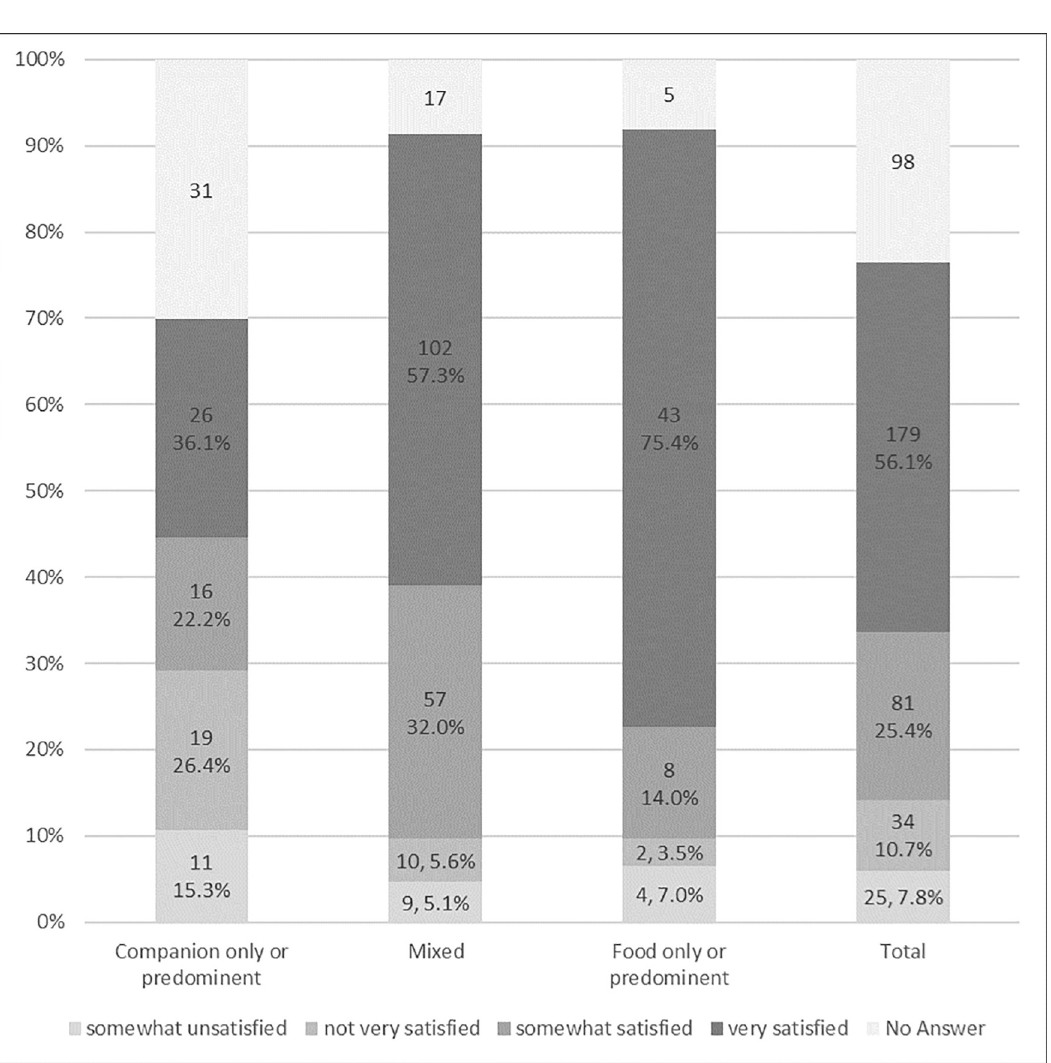
Fig 5. Satisfaction level of small-scale livestock and poultry owners by type of veterinarian practice in 4 western states (Washington, California, Colorado and Oregon). Footnote : Proportions are given as the valid percentage: the percentage only of individuals who answered the question, and do not count no